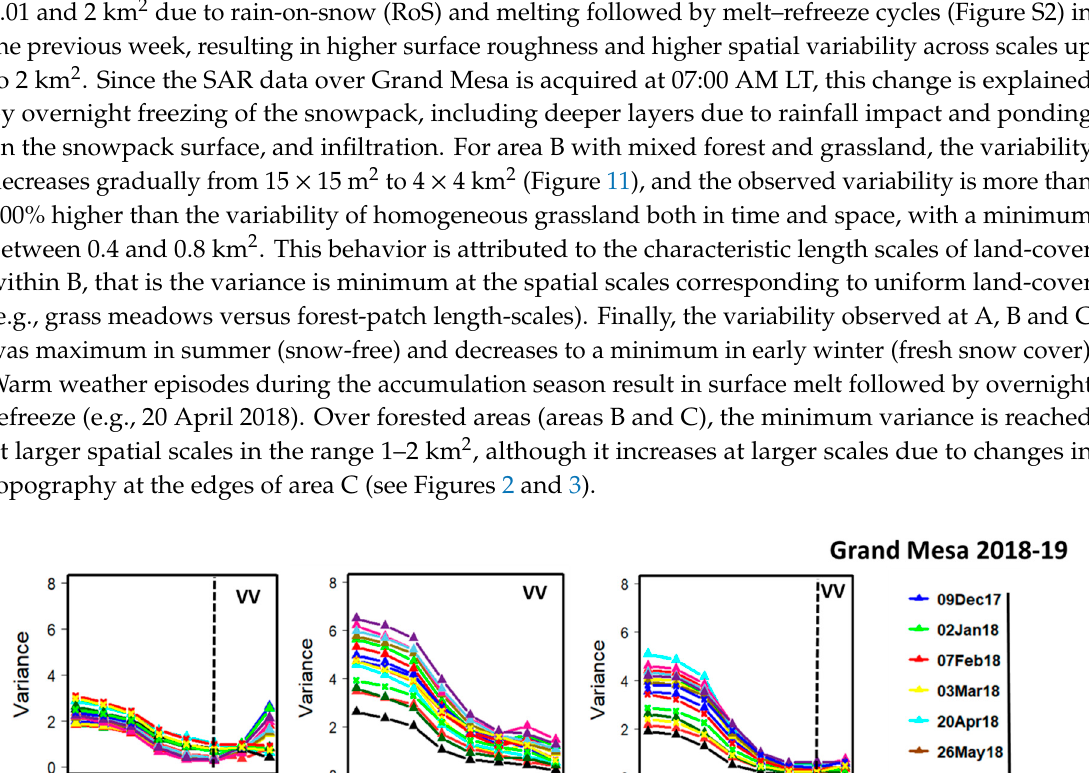
Figure 12. Temporal evolution of the spatial variance of Sentinel-1 VV ( left ) and VH ( right ) BSC coefficients in ascending mode for homogenous barren land covered with snow in the winter time over the Swiss Alps, Davos during 2018 as a function of scale. Over the smooth topography of North Dakota, BSC variability also decreases gradually with spatial scale (Figure 13) reaching a minimum at field scale (1 km 2 ). Maximum variability in the snow